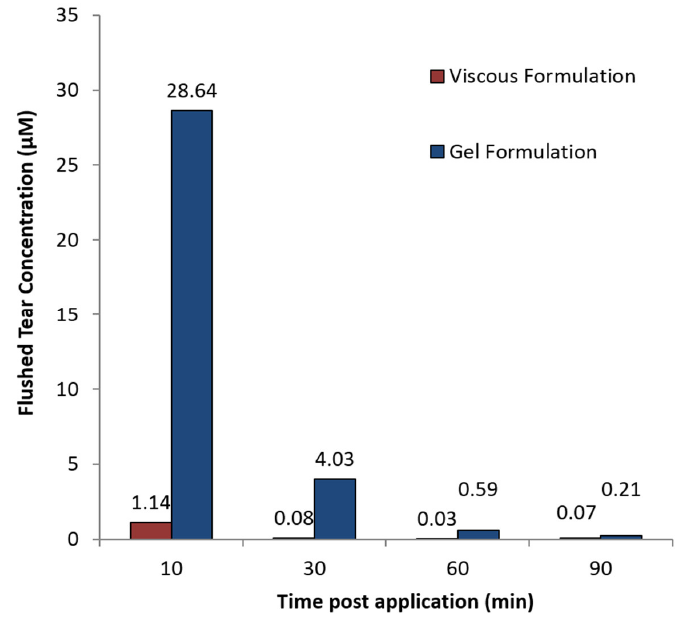
Figure 7. Senicapoc concentration in flushed tears after topical administration of hydrogel formulations in anesthetized Sprague-Dawley